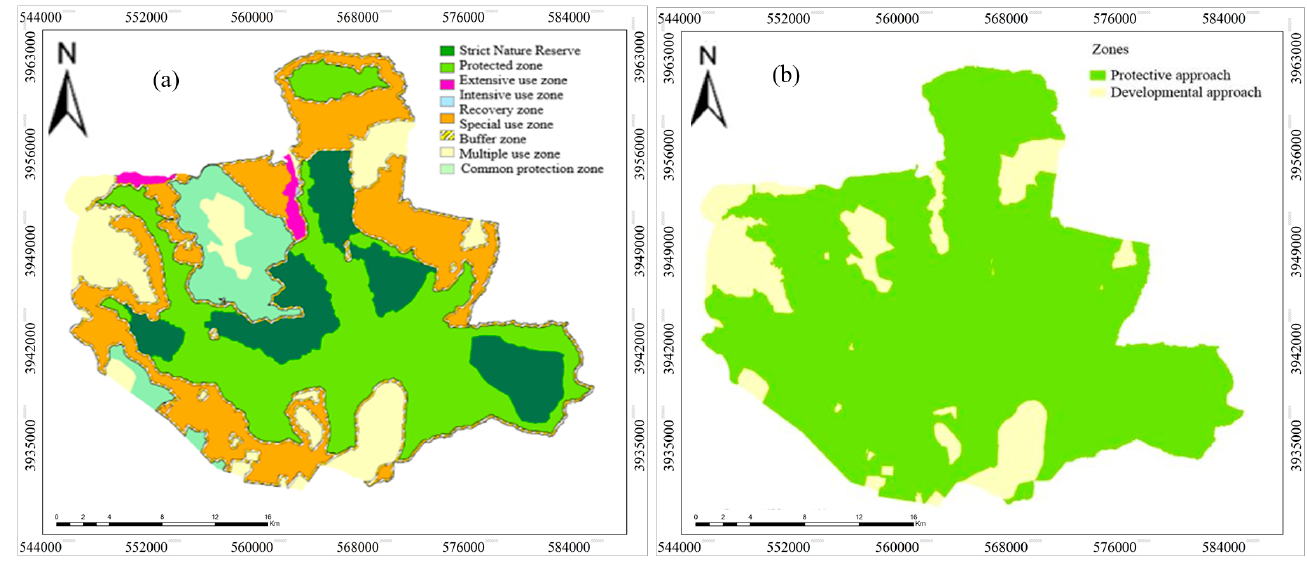
Figure 6. Zoning of the Jajrud Protected Area with ( a ) identified zones, ( b ) with an either protective or developmental approach to management.